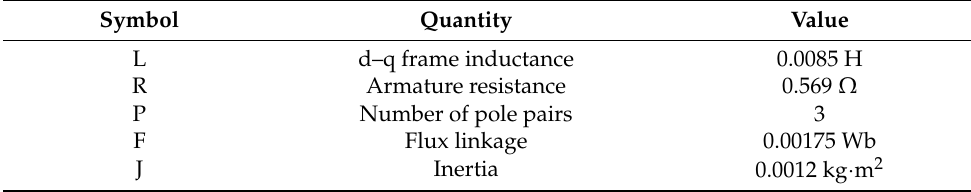
Table 1. Parameters of the permanent magnet synchronous motor